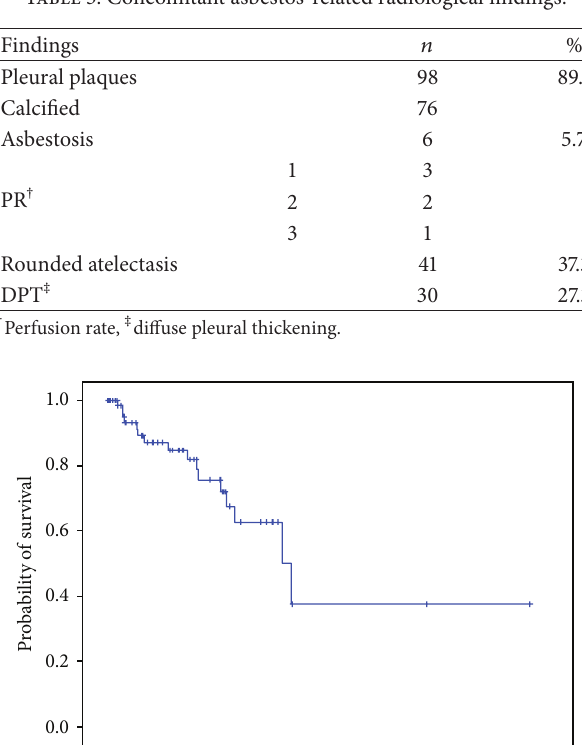
Table 2: Occupational category related to asbestos exposure. Table 3: Concomitant asbestos-related radiological findings.